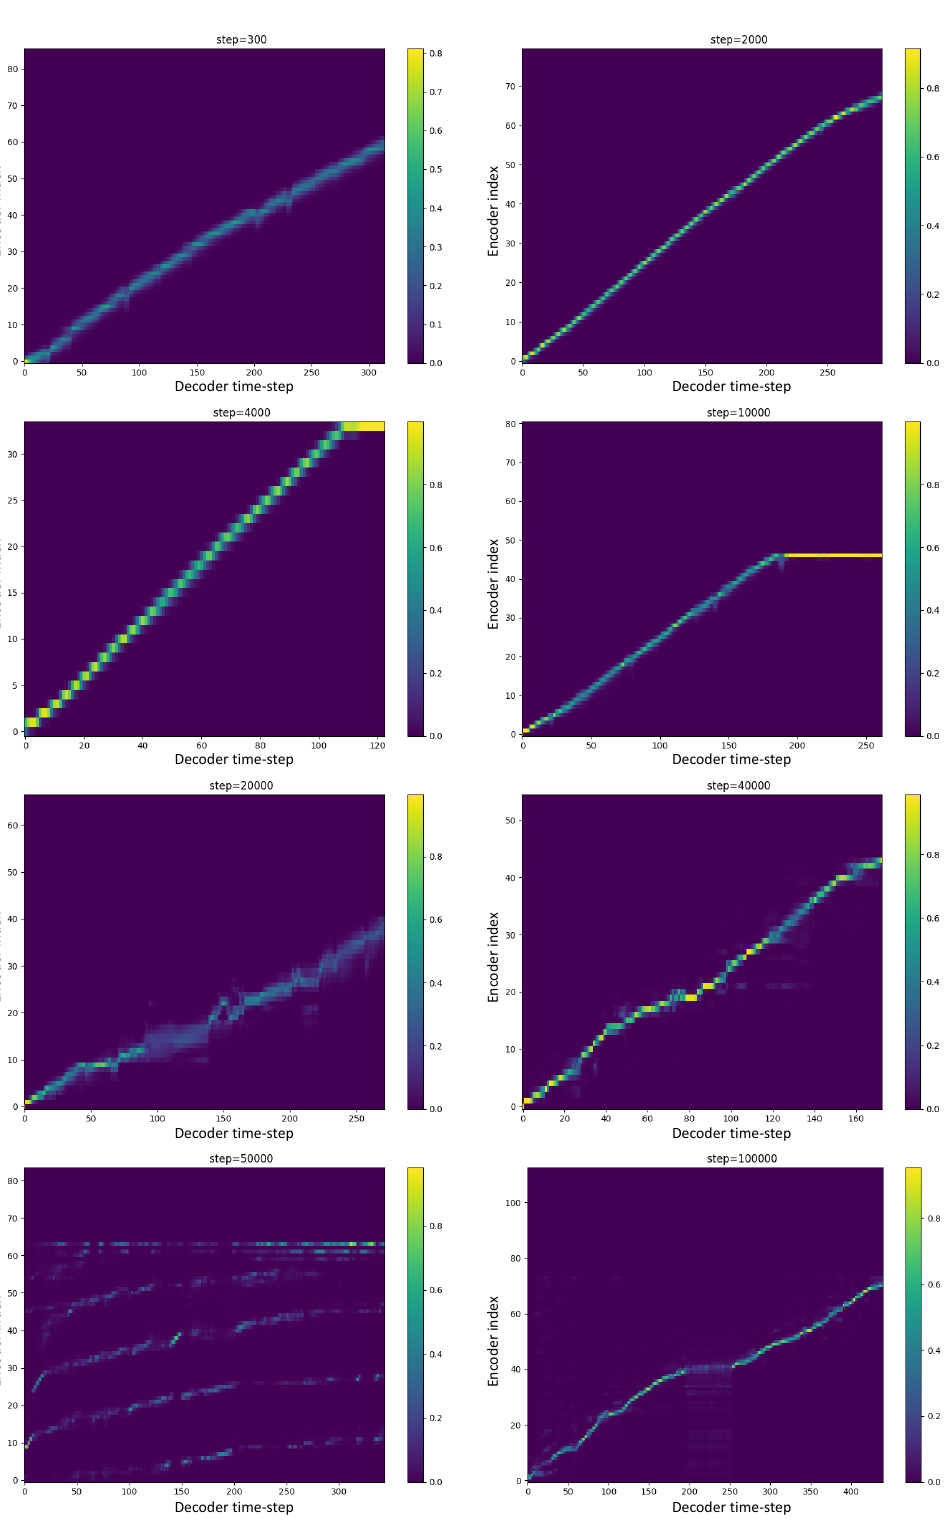
Figure A1. Attention plot during training Tacotron2-GST-LSA with guided